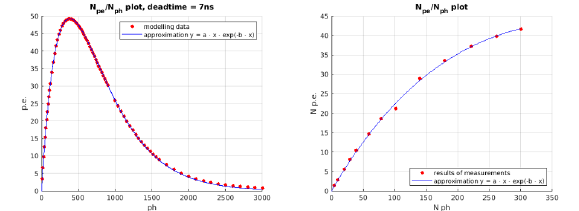
Figure 9. Left: simulated pile-up curve with δ t = 7.5 ns. Right: Example of a pile-up curve, measured for one pixel and fitted with ε = 0.25 and δ t = 8.3